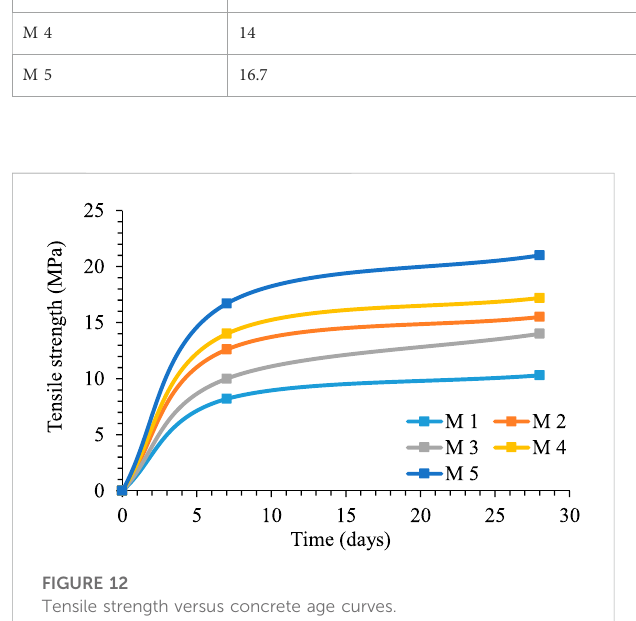
Tensile strength versus concrete age curves.